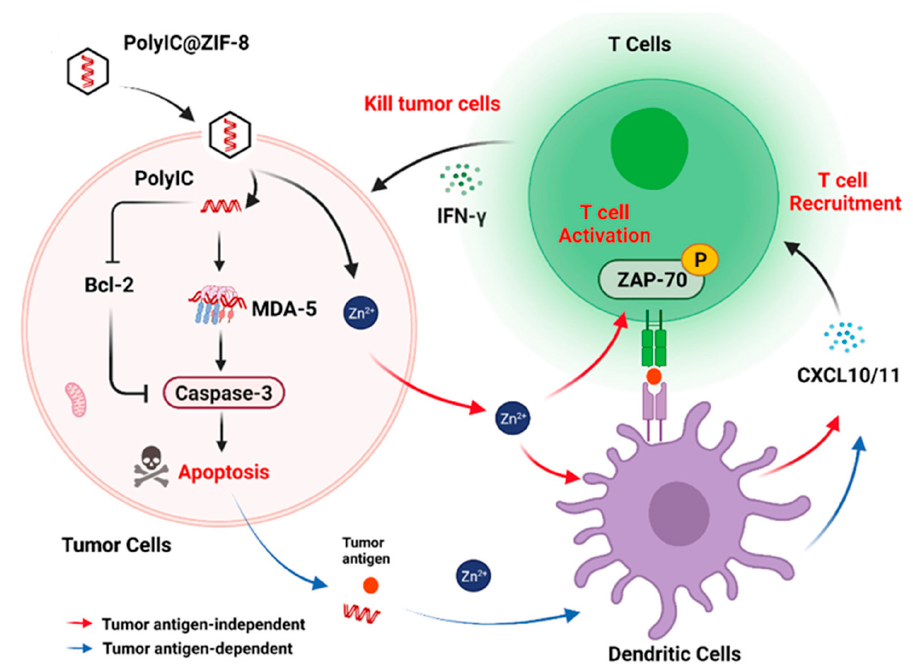
Figure 10. Schematic illustration of the oncolytic virus–like PolyIC@ZIF–8 nanoparticles that promote T cell recruitment and activation for tumor immunotherapy. Reproduced from Ref. [139] with permission from Wiley–VCH, copyright 2022.